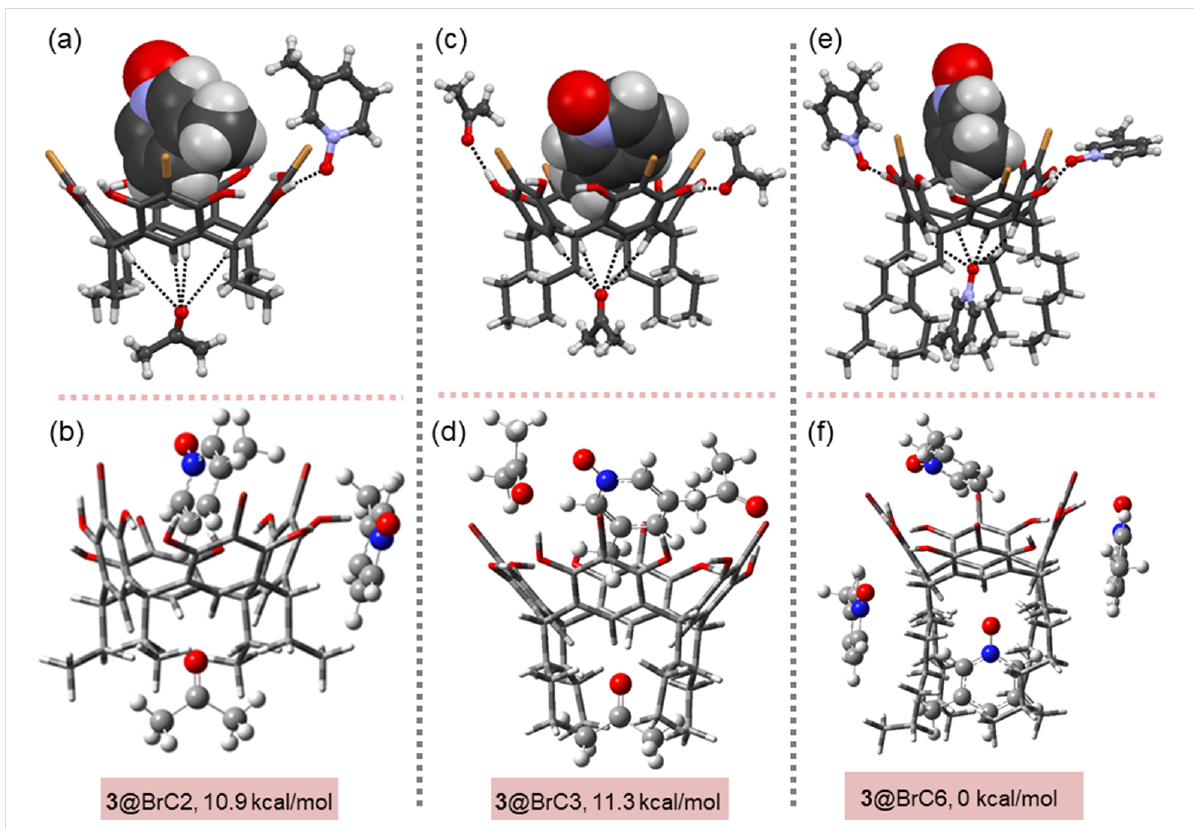
Figure 3: Comparison of X-ray crystal structures (a) 3 @BrC2, (c) 3 @BrC3, and (e) 3 @BrC6 and their DFT-based optimised geometries (b) 3 @BrC2, (d) 3 @BrC3, and (f) 3 @BrC6, respectively.